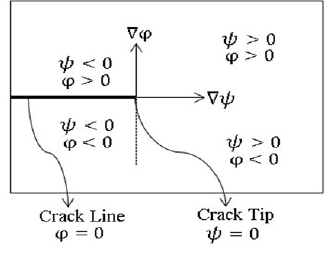
Figure 1. Crack line function φ and crack tip function Ψ